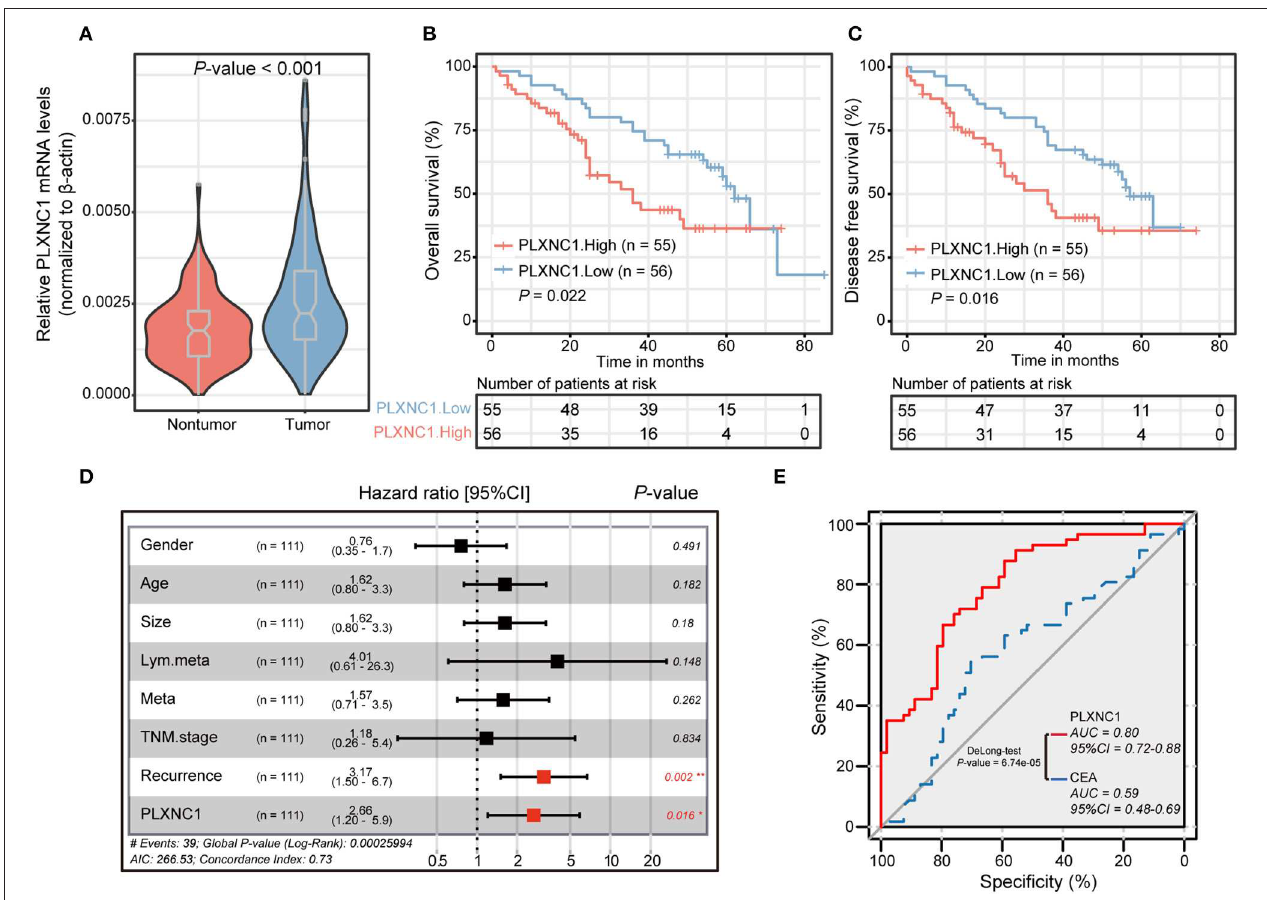
FIGURE 2 | PLXNC1 predicts prognosis in gastric cancer. (A) The differential expression level of PLXNC1 expressed in our 111 paired STAD tissues. (B,C) Kaplan–Meier curves of overall survival and disease-free survival in our internal 111 gastric patients, validated by PLXNC1 mRNA expression levels. (D) The results of multi-variate analyses using the Cox proportional hazard regression model for PLXNC1 mRNA levels and other clinical indices in our internal cohort. (E) The comparison of diagnostic efficacy of CEA and PLXNC1 mRNA levels for predicting the time period of tumor OS. * P < 0.05; ** P <